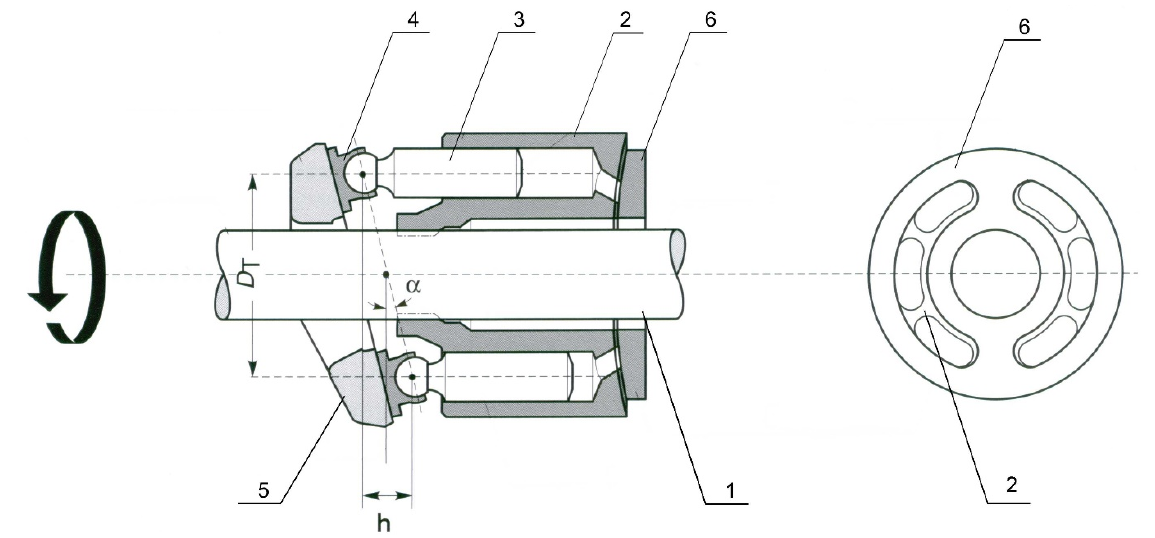
Figure 1. Simplified design diagram of a swashplate axial piston pump: 1—shaft, 2—rotor, 3—piston, 4—sliding shoe, 5—swashplate, 6—valve plate [20].